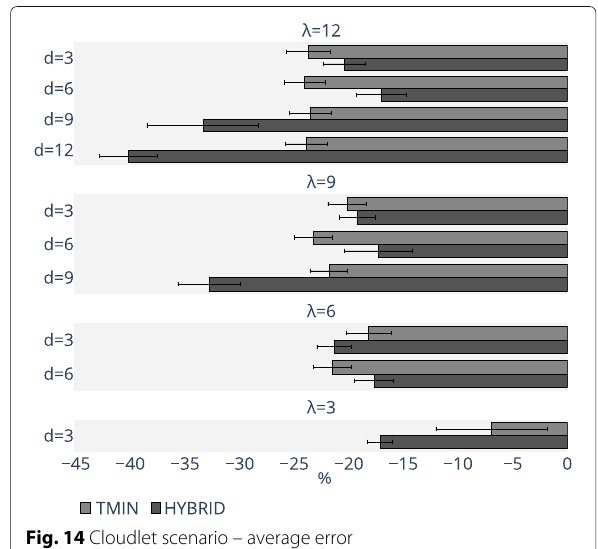
Fig. 14 Cloudlet scenario – average error